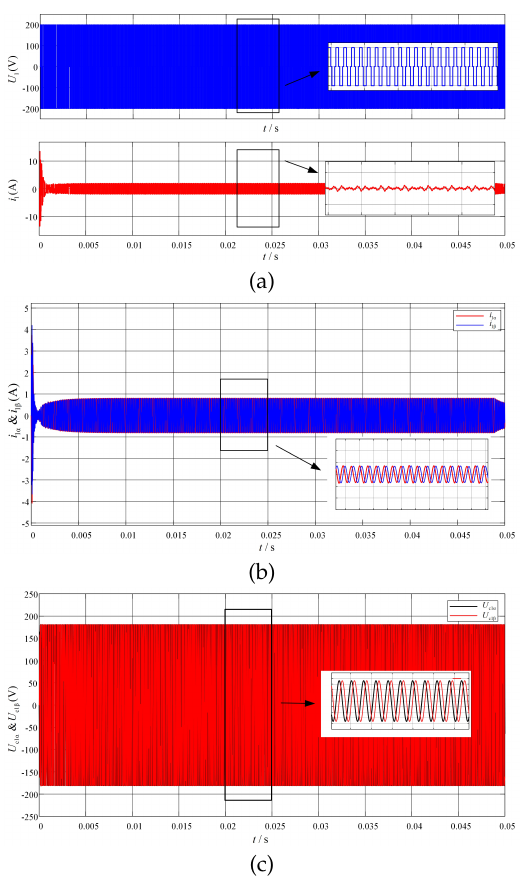
Fig. 9. (a) Output voltage and current of inverter , (b) Two phase quadrature current of SOGI-QSG, (c) Two phase quadrature voltage of SOGI-QSG